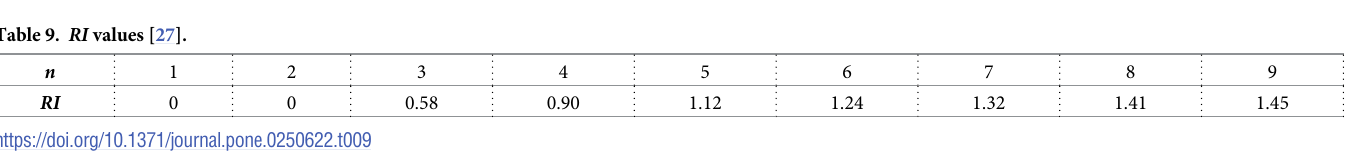
By comparing the scores of each region with the distribution map, the information transmis- sion system of Wenzhou in Ming Dynasty is strong in coastal, southern and northern regions and weak in inland and central regions. From the distribution map of information transmission system (Fig 3), it can be clearly seen that most of the Wei cities, Suo cities, beacon towers, post stations and urgent delivery stations were constructed in coastal areas. On one hand, the coastal terrain of Wenzhou was relatively flat, which was suitable for the construction of various facilities. On the other hand,